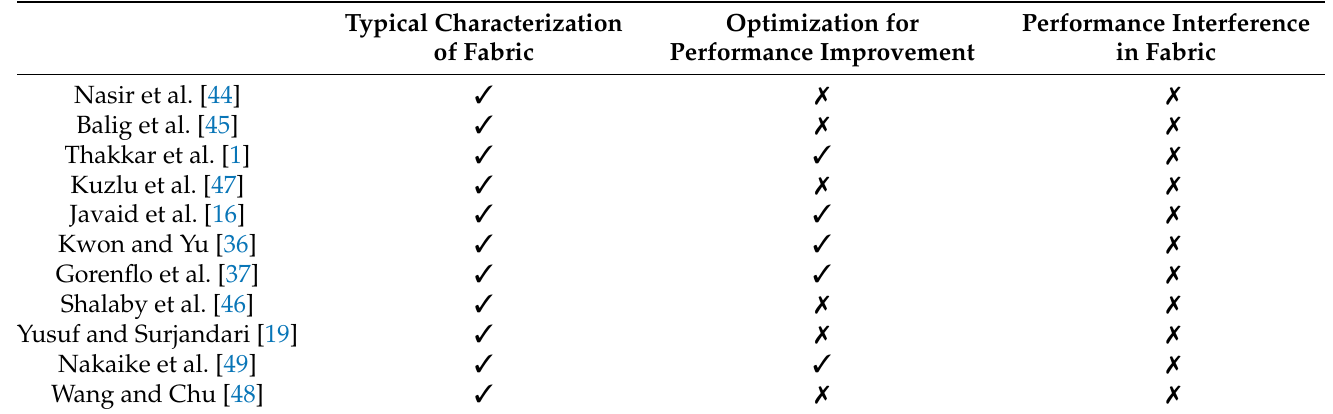
Table 6. Comparison of related work in terms of Fabric